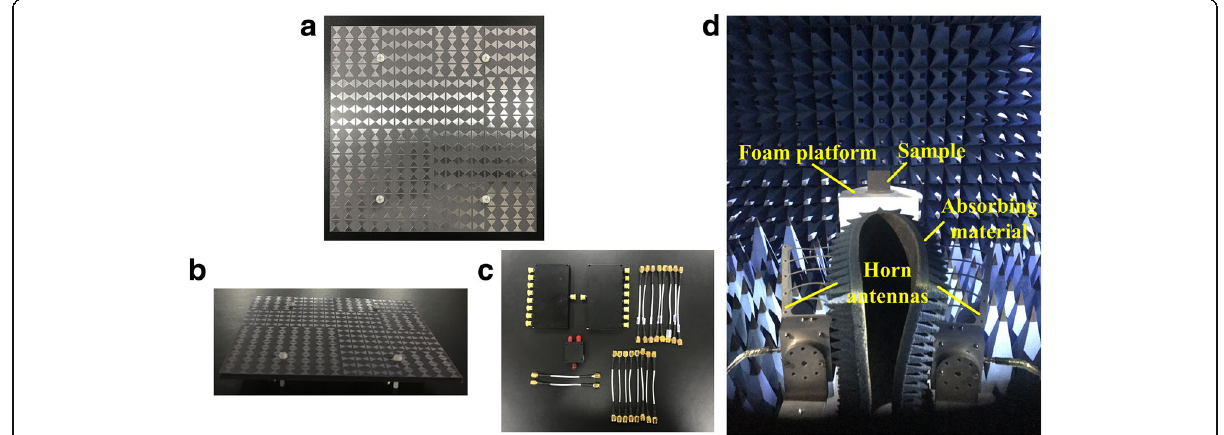
Fig. 12 a , b Fabrication of the EMMS sample top view ( a ) and side view ( b ). c Power divider. d Basic measurement setup for